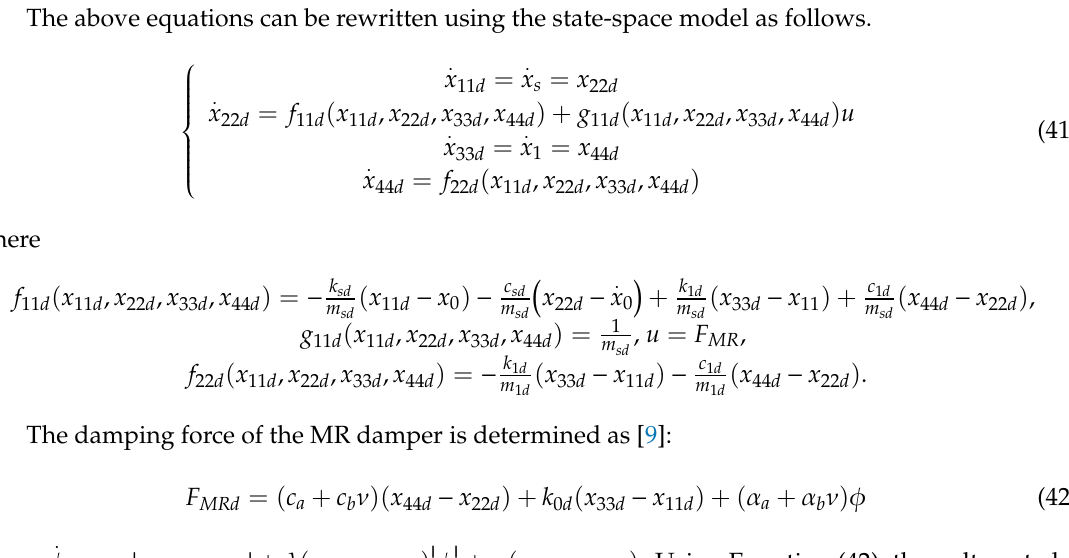
Figure 1. Mechanical model of the seat suspension with MR damper.